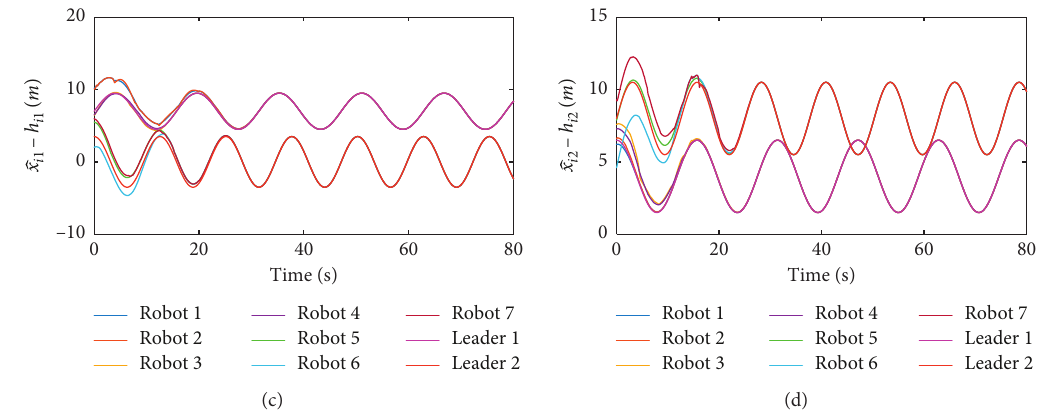
Figure 11: Evolution of x